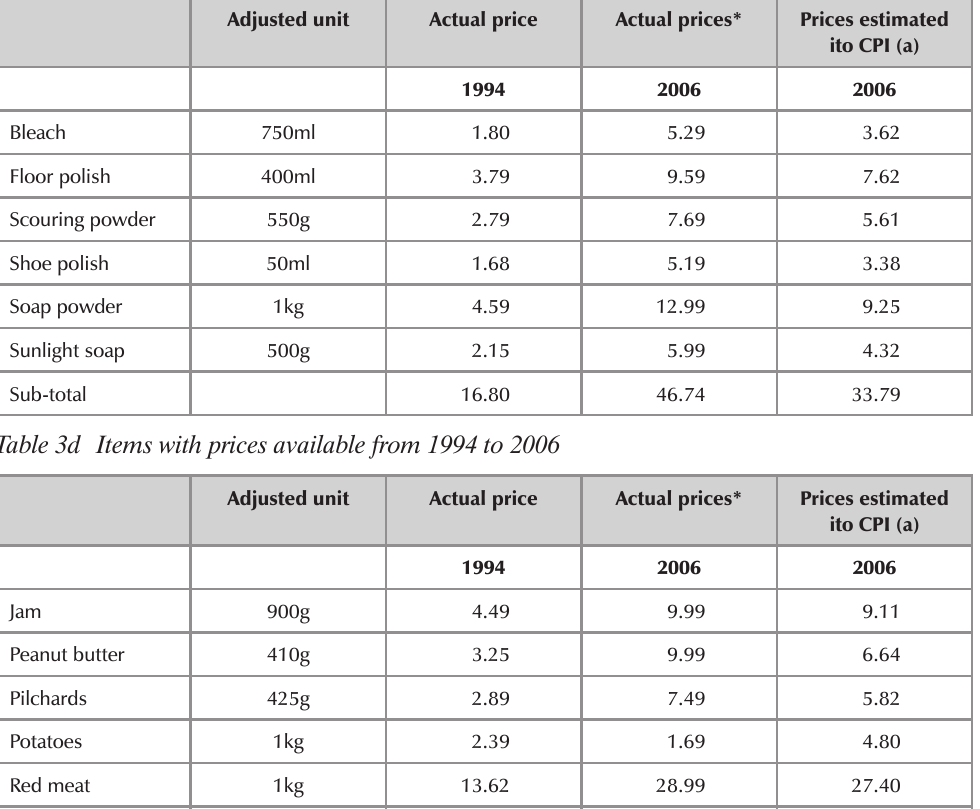
Table 3c Average prices of household consumables (all prices in R) (c)